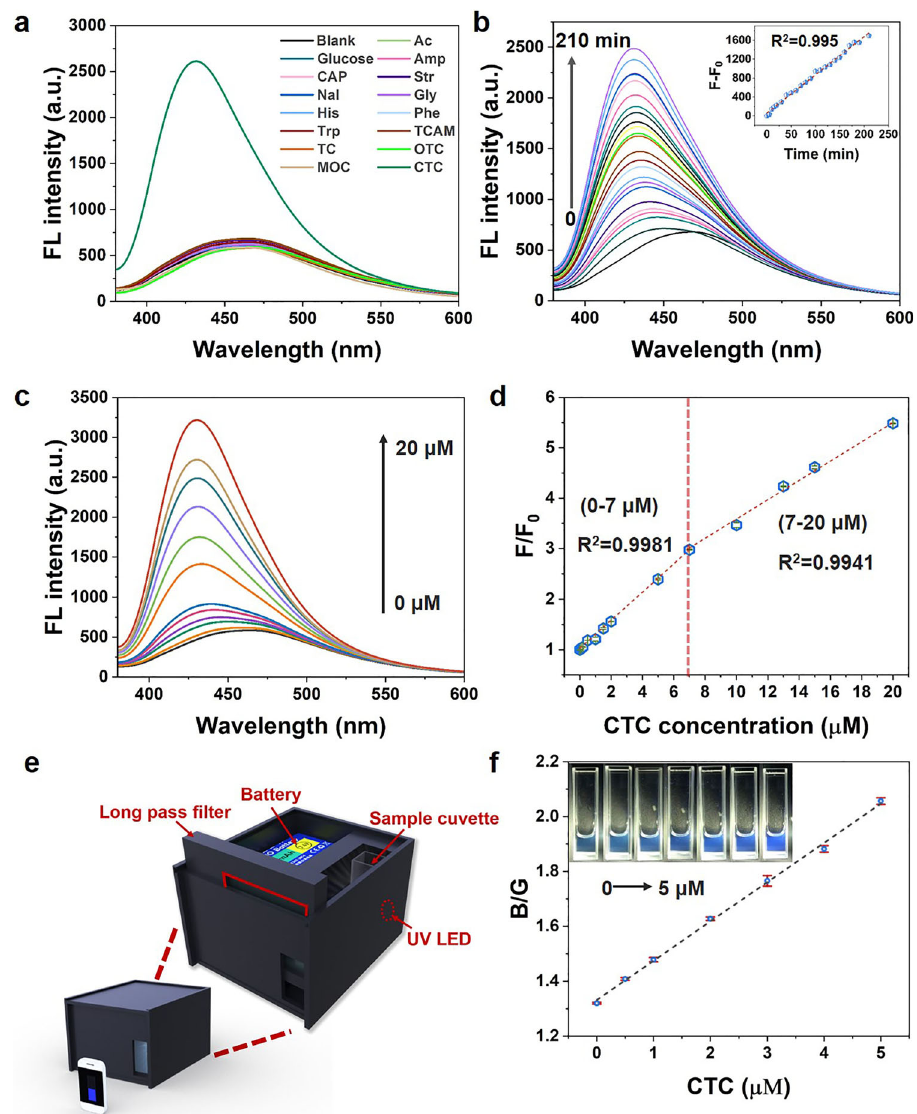
Fig. 6 | Detection of CTC with CDHis. a FL spectra of CDHis after addition of various common organics ( λ ex =356nm, AC acetic acid, glucose, Amp ampicillin, CAP chloramphenicol, Str streptomycin, Nal nalidixic acid, Gly glycine, His histi- dine, Phe phenylalanine, Trp tryptophan, TCAM trichloroacetamide, TC tetra- cycline, OTC oxytetracycline, MOC minocycline). b Fluorescence spectraof CDHis ( λ ex =356nm, 1.25mM) at different time durations after adding 10 μ M CTC. c The evolution of fl uorescent spectra of CDHis ( λ ex =356nm) with different CTC